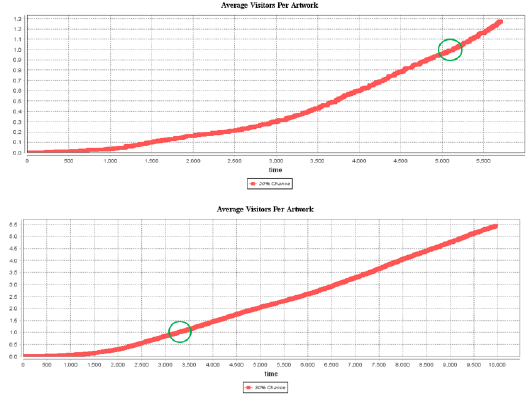
Figure 13. Average number of viewers per artwork for 10%, 20%, and 30% chance respectively.